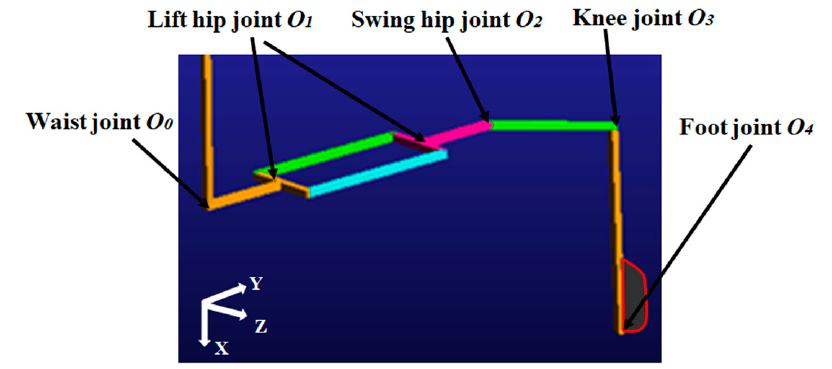
Figure 6. Foot trajectory simulation.